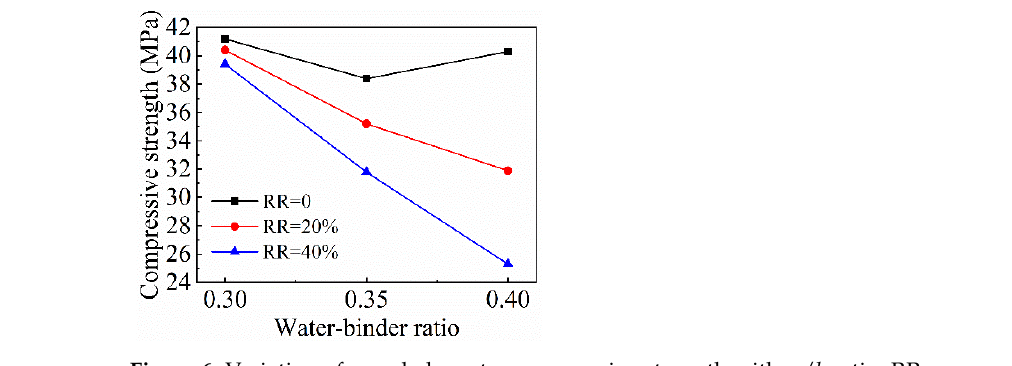
Figure 6. Variation of recycled mortar compressive strength with w / b ratio. RR represents replacement ratio of fly ash.